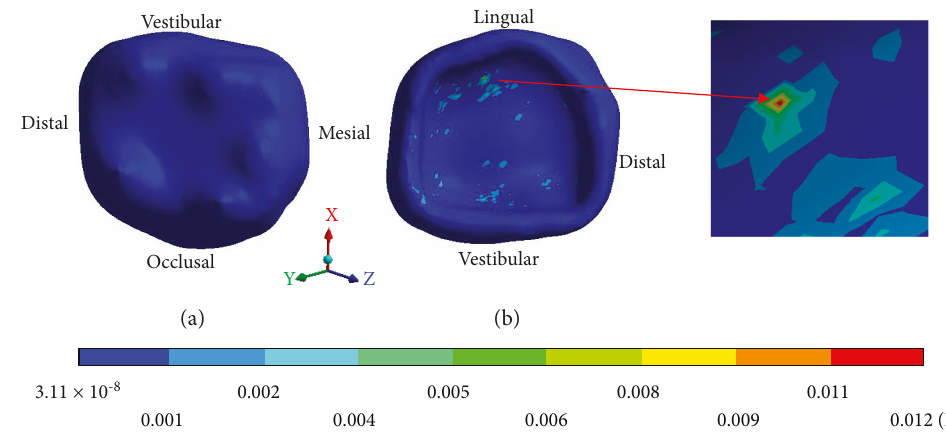
Figure 6: Control case: von Mises stresses in enamel: (a) occlusal view (b) cervical view.